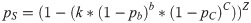
Simulation showing effects of adding a CTL-mediated vaccine to an antibody-mediated vaccine.Simulations were performed using the equation pS=(1−(k*(1−pb)b*(1−pC)C))Z where pS is the probability of sterile protection, k the natural infectivity of sporozoites, pb and pC the probability of protection parameters with antibodies b and cytotoxic T-cells C respectively. Using experimentally-derived values of pb = 0.022 and pC = 1.21E-04, (A) shows a simulation of the effect of increasing antibody concentration with various fixed concentrations of cytotoxic T-cells. (B) shows that combining an antibody-inducing vaccine of 45% efficacy with a CTL-inducing vaccine of 21% efficacy is predicted to give a protective efficacy of 97%.